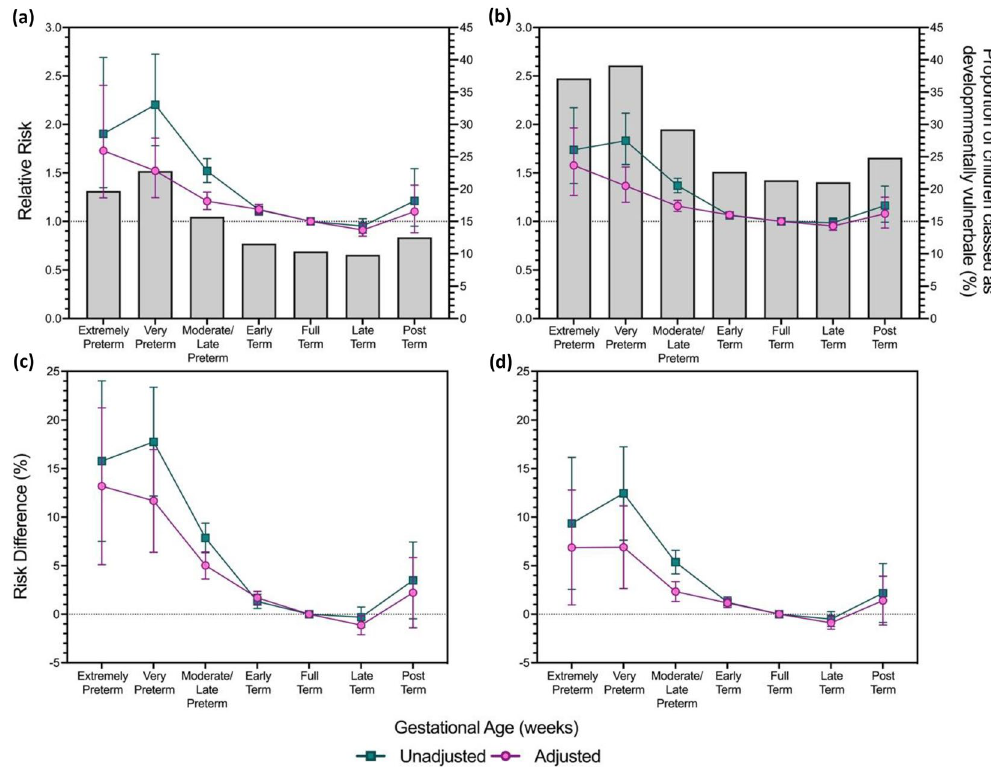
Figure 2. Unadjusted and Adjusted, Relative Risk and Risk Difference from interaction models for the association between developmental vulnerability on the Australian Early Developmental Census (AEDC), and gestational age. The proportion of the study population classified as developmentally vulnerable (a) on one or more AEDC domains, and (b) on two or more AEDC domains, overlayed with relative risk of developmental vulnerability for each outcome, compared to children born at full-term, and the risk difference of developmental vulnerability on (c) one or more the AEDC domains, and (d) two or more AEDC domains. Developmental vulnerability was defined as scores in the bottom decile, based on the 2009 AEDC cut-offs. Adjusted model based on pooled analysis from 20 imputed datasets controlling for; maternal age at time of child’s birth, maternal marital status at time of child’s birth, maternal ethnicity, maternal immigration status, maternal occupational status at time of child’s birth, parity, age of child at time of AEDC completion, child’s sex, preschool attendance, child speaks a language other than English at home, child’s reading status, total number of siblings, and Index of Relative Socioeconomic Disadvantage category. All relative risk and risk difference data is presented with 95% confidence intervals; modified Poisson